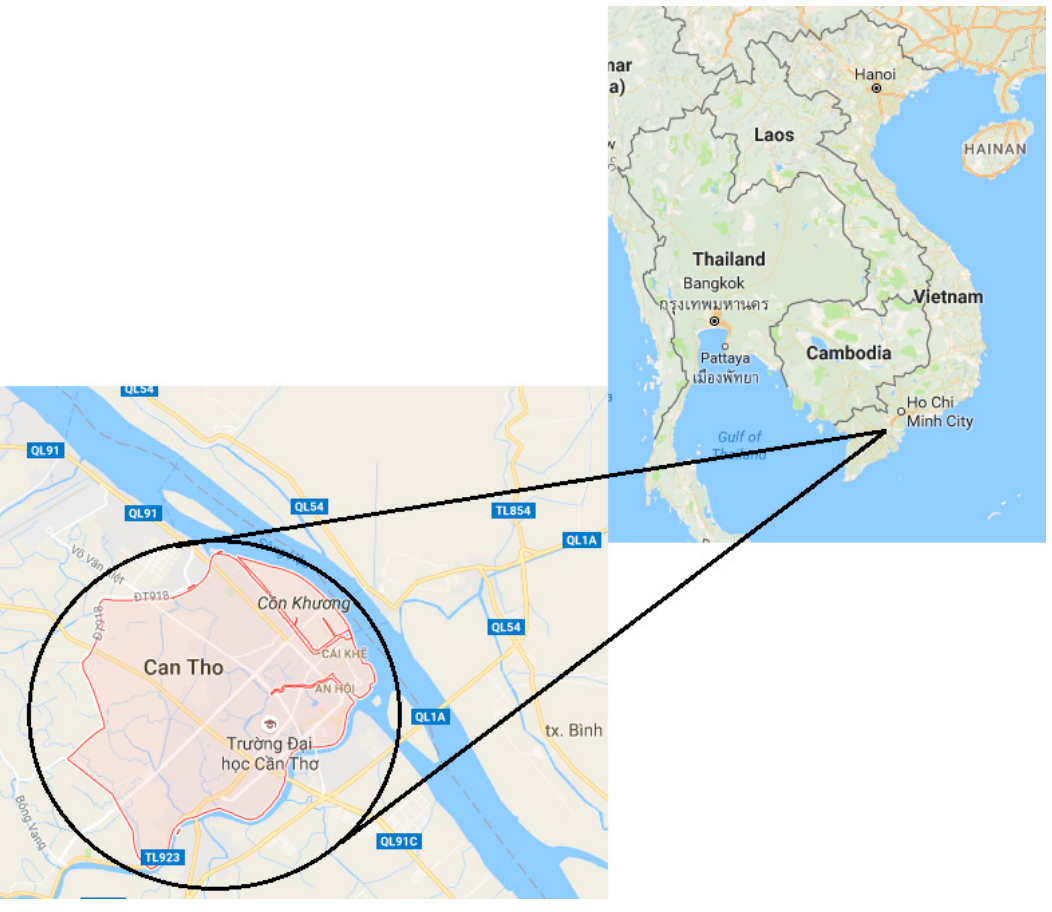
Figure 2. Map showing location of Can Tho (Source: Google Maps Website, https://goo.gl/maps/6D73uLoJYj82).